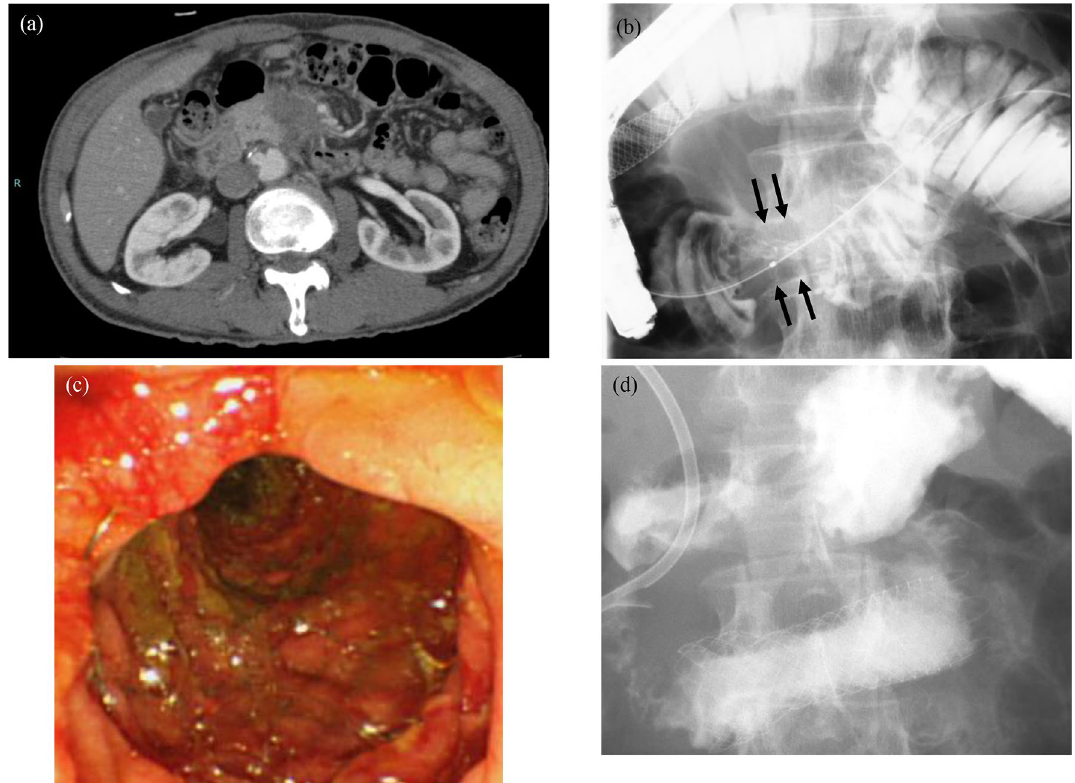
Figure 2. Images of a 70-year-old man with metastatic pancreatic cancer. Both his Gastric Outlet Obstruction Scoring System (GOOSS) and Glasgow Prognostic Score were 0 before duodenal stent (DS) placement. ( a ) Computed tomography revealed a pancreatic tumor with duodenal invasion. ( b ) Fluoroscopic imaging shows a severe D3 stricture (arrows). Endoscopic ( c ) and fluoroscopic ( d ) images show the resolution of the stricture after DS placement, which has improved the GOOSS to 3. He received chemotherapy and achieved long-term survival (901 days) without re-intervention of the